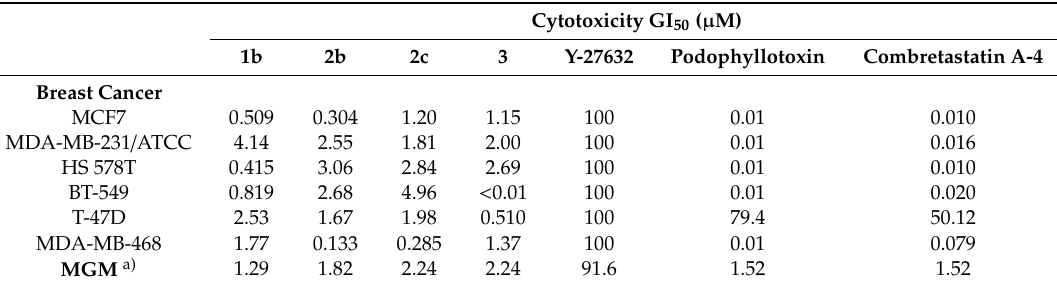
Table 1. Mean dose percent values by one-dose assay (10 − 5 M) of all the tested compounds in the full NCI 60 cell panel.